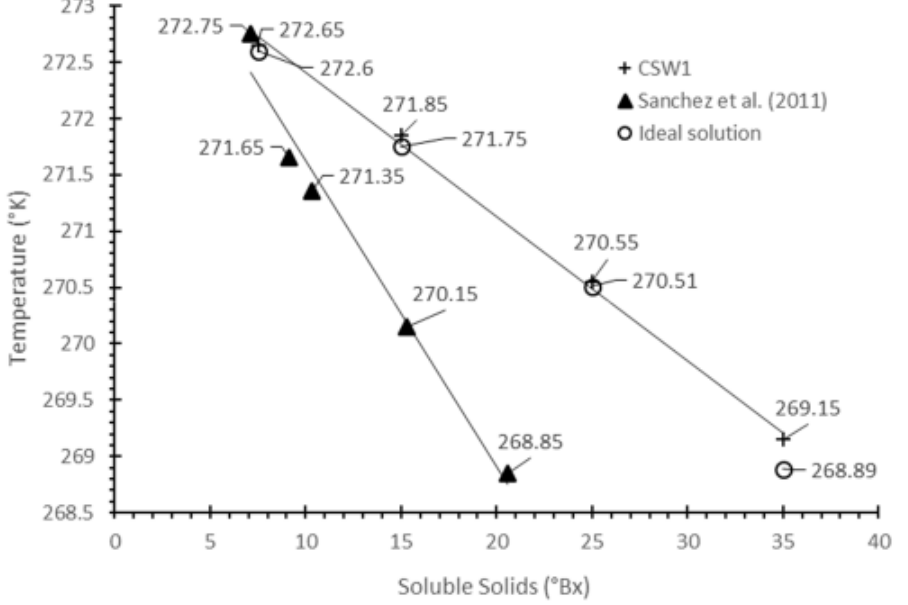
Figure 2. Freezing point ( ◦ K) of the CSW1 whey and an ideal solution, as a function of the soluble solids content ( ◦ Bx).